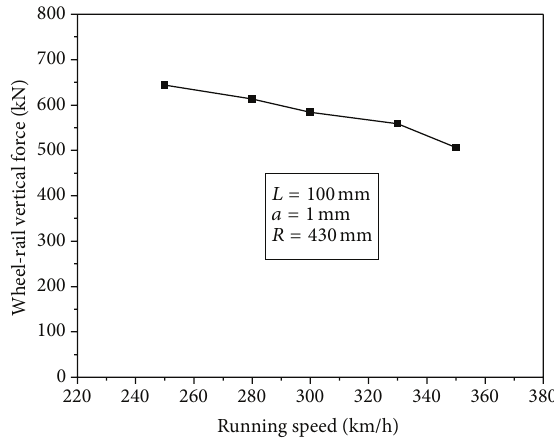
Figure 16: Wheel-rail vertical force versus running